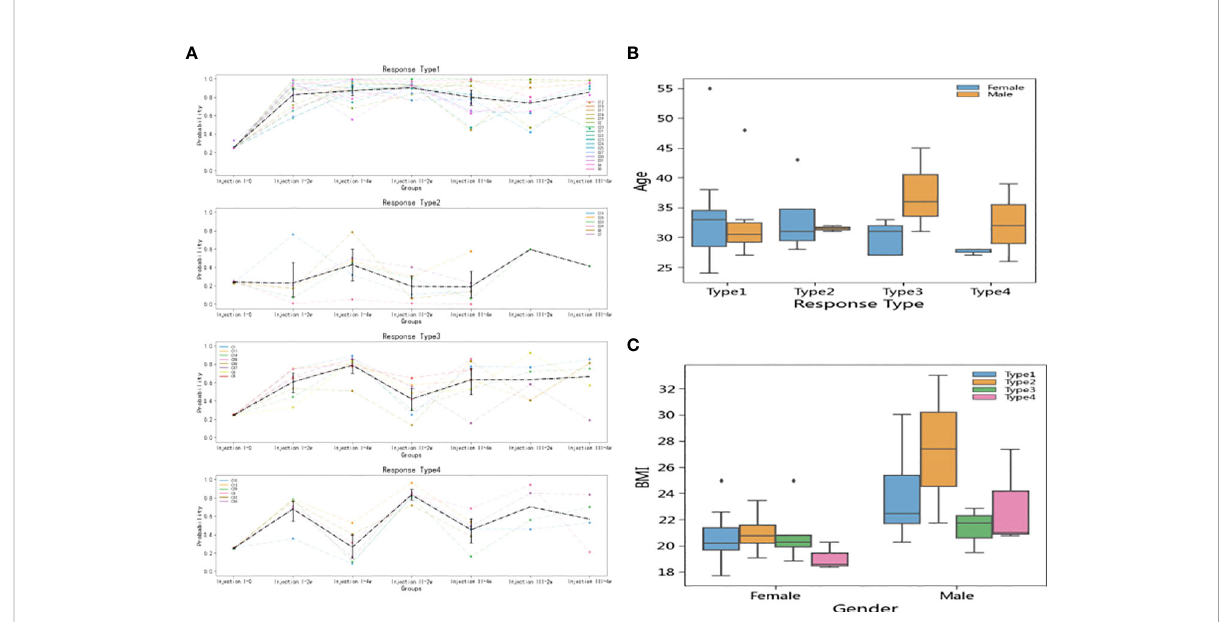
FIGURE 5 Inoculation reaction types and relationship of types to individual factors. (A) Types were de fi ned according to k-means clustering, with Type 1 showing strong antibody responses, Type 2 showing weak responses until the third dose, Type 3 showing a lasting response to the fi rst dose, and Type 4 showing a notable boosts in immune response to follow-up doses. (B) There was no signi fi cant difference between the age distributions of men and women in terms of vaccine response. (C) Type 2 participants (poor responders to doses 1 and 2) had higher BMI values than participants in the other type groups. The effect was signi fi cant in both women and men, but dramatically more pronounced in men than in